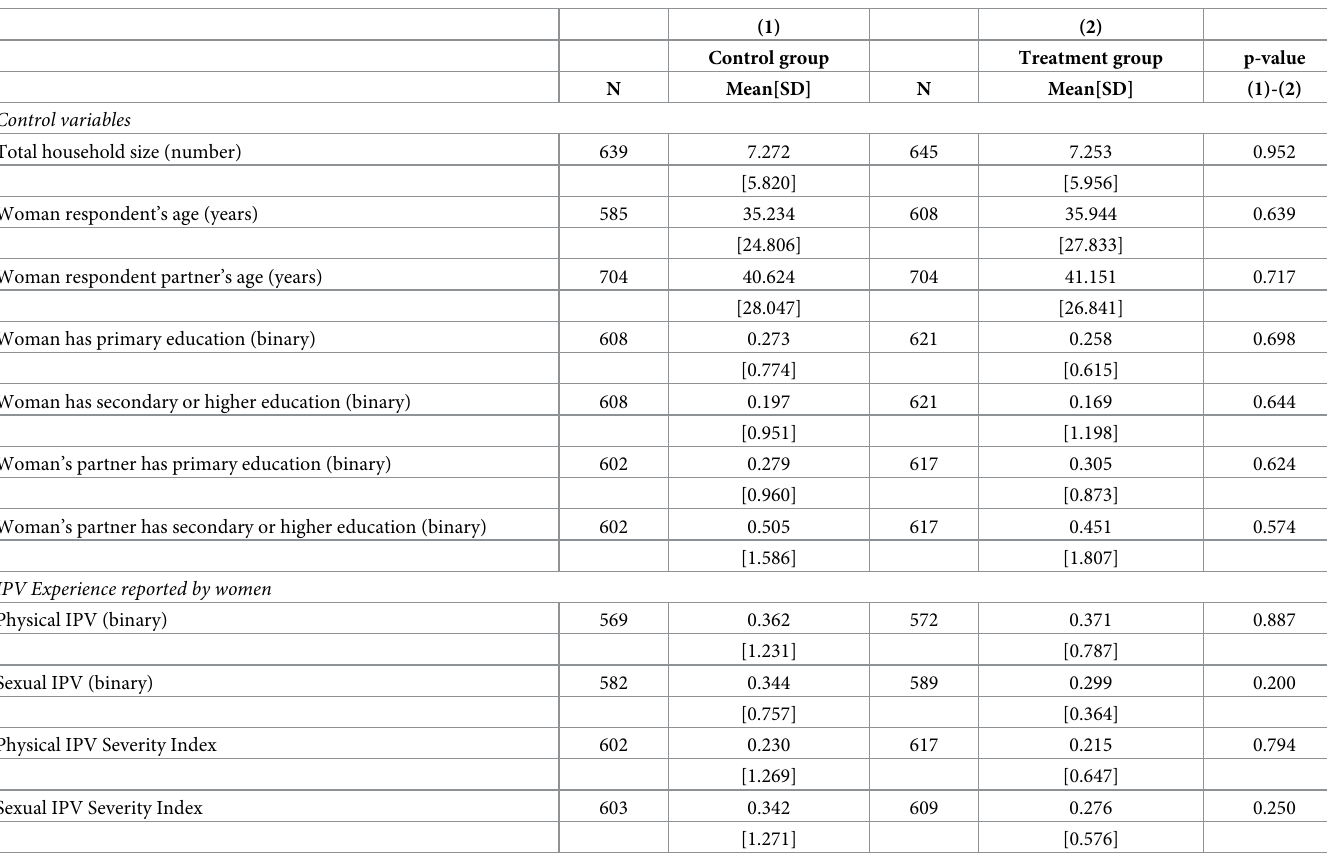
Table 2. Baseline characteristics by study arm.